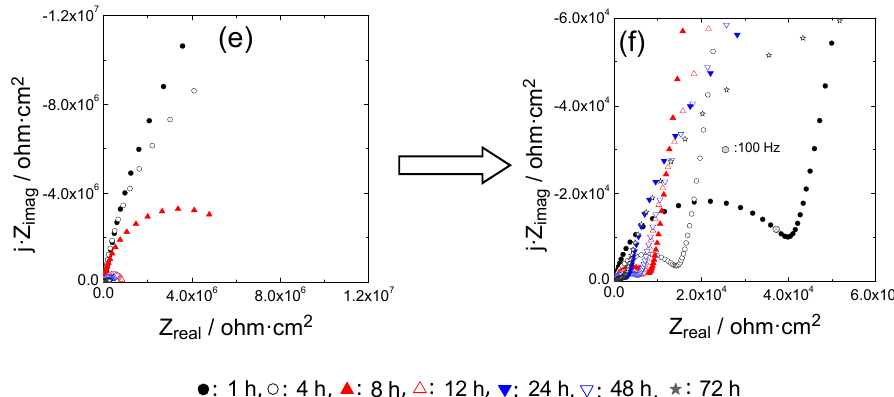
Figure 10. Nyquist impedance plots for different AA2024-T3/sol-gel coating systems: sample 21 (( a ) and ( b )), sample 31 (( c ) and ( d )) and sample 41 (( e ) and ( f )). Test electrolyte: 0.05 M NaCl aqueous solution. Immersion time: 1 h, 4 h, 8 h, 12 h, 24 h, 48 h and 72 h.